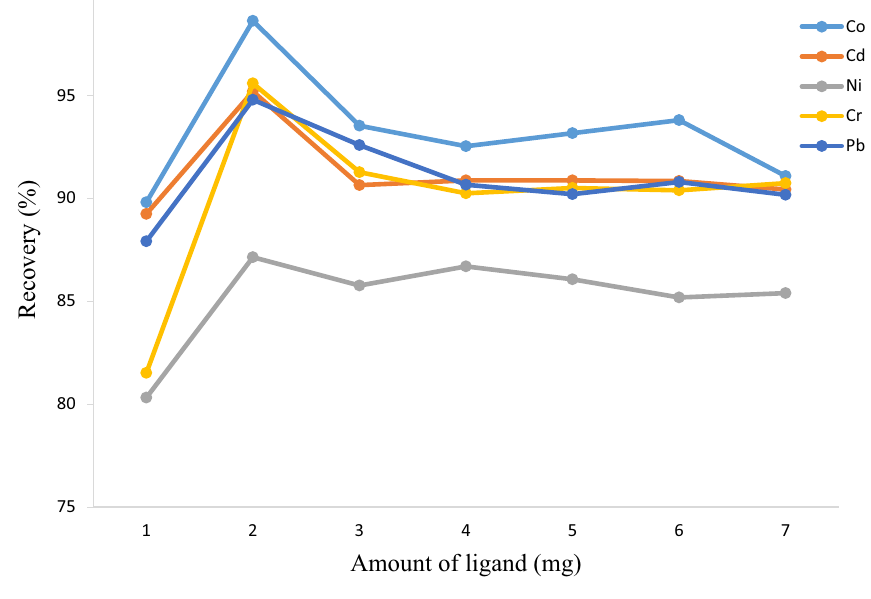
Fig. 4 Effect of 8-hydroxylquinoline as ligand on heavy metal